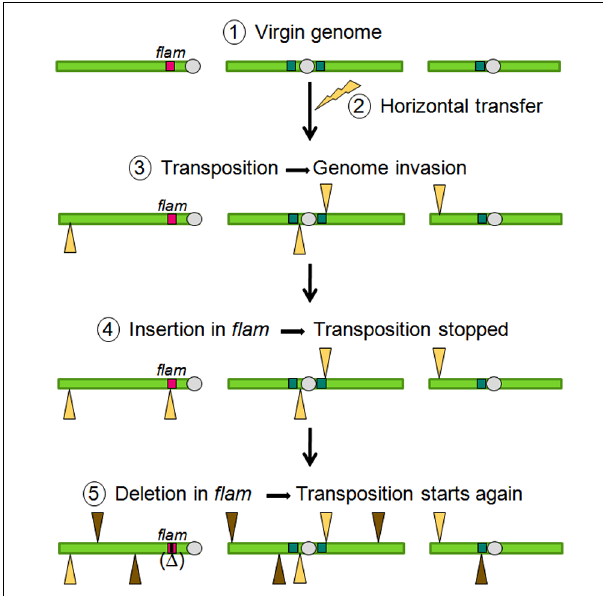
FIGURE 5 | Model ofTE invasions, silencing, and remobilization.